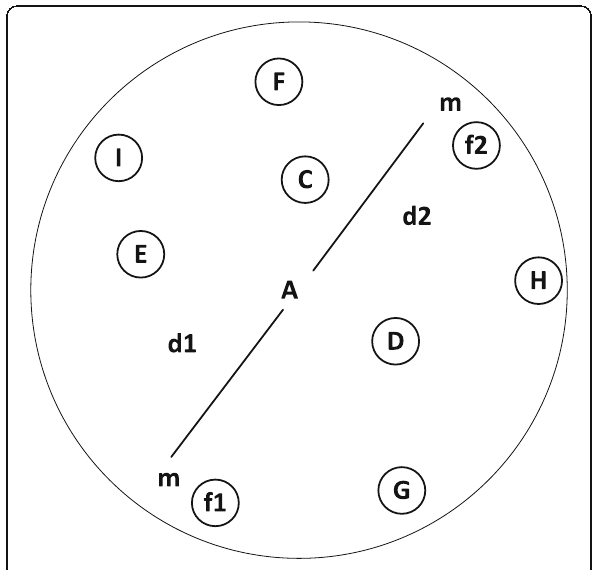
Fig. 1 Spoofing in same radio range. Represents the mobile nodes A, C, D, F, G, H, I and M that lie in the local radio range for which experiment is